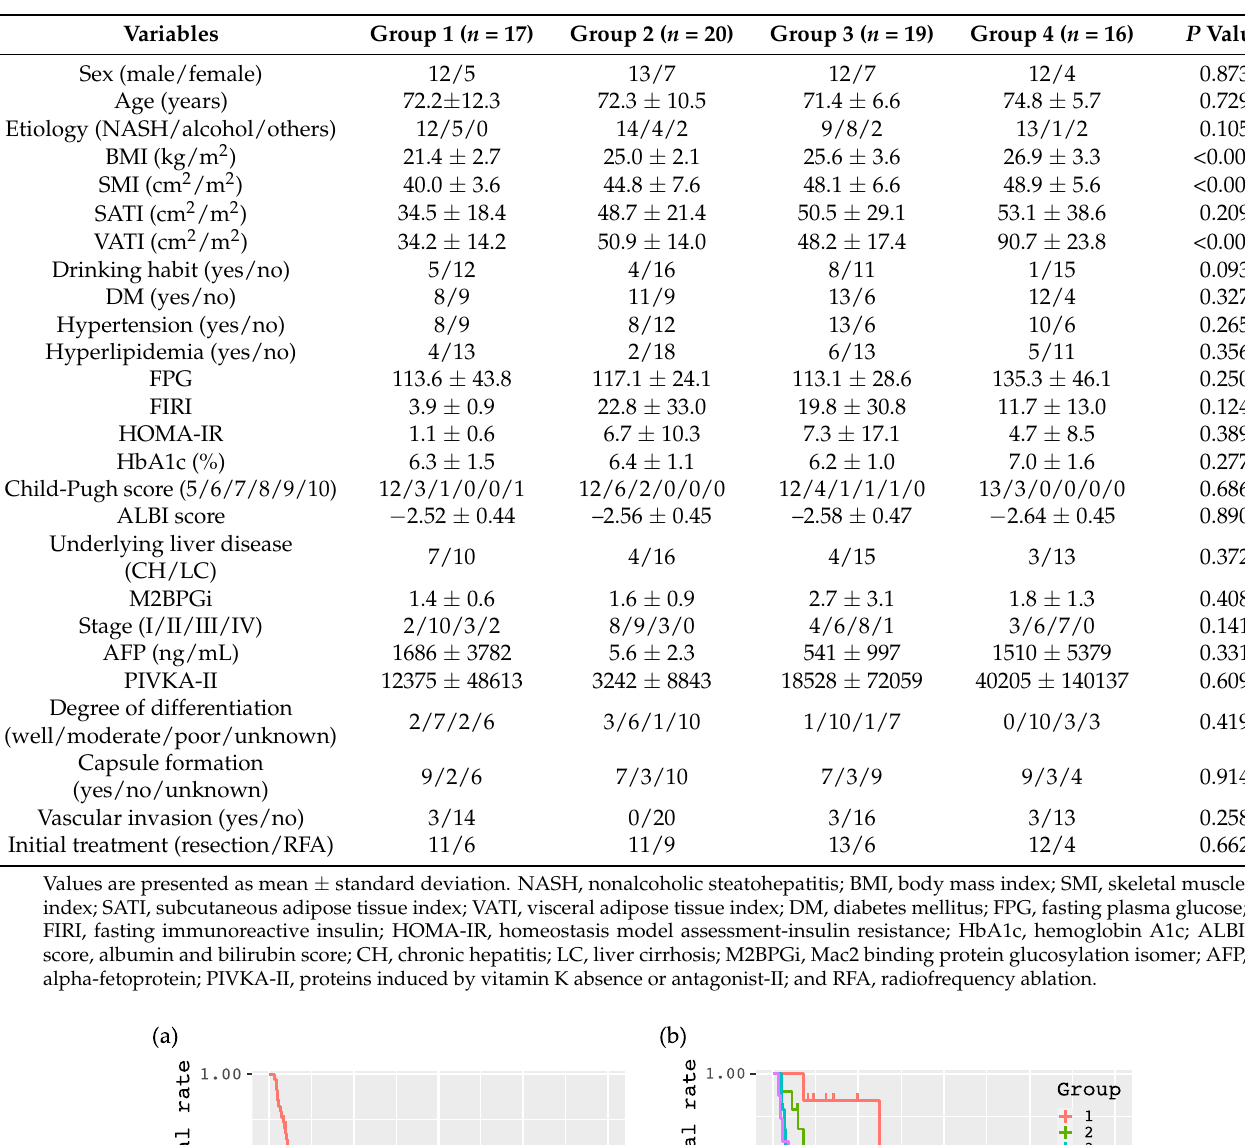
Table 3. Baseline demographic and clinical characteristics of the enrolled patients with primary non-B non-C HCC divided into four groups according to the decision-tree analysis